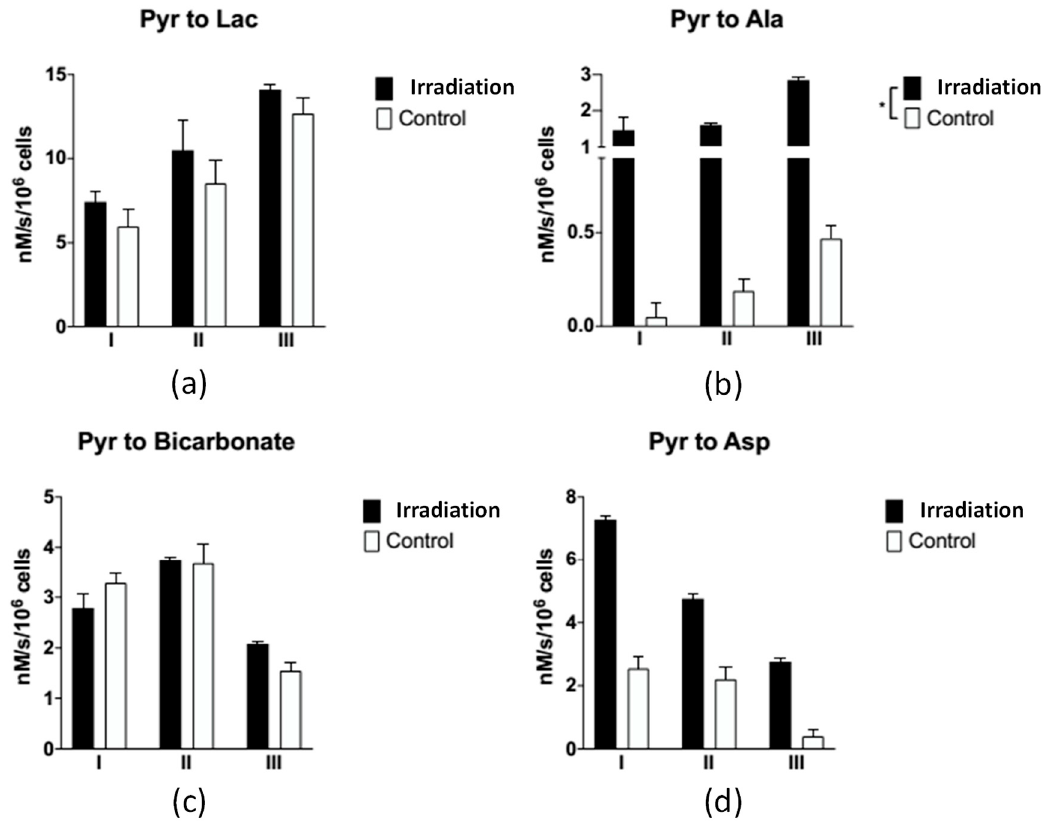
Figure 4. The apparent exchange rate constants of each metabolite between the irradiated and con- trol groups for three measurements. These numbers are listed in Table S2. ( a ) Pyruvate to lactate; ( b ) pyruvate to alanine (“*” represents p < 0.05); ( c ) pyruvate to bicarbonate; ( d ) pyruvate to aspar- tate.